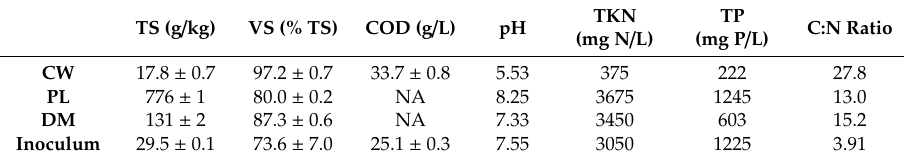
Table 2. Characterization of the substrates, cassava wastewater (CW), poultry litter (PL), and dairy manure (DM) and the inoculum source, including total solids (TS), volatile solids (VS), chemical oxygen demand (COD), pH, total Kjeldahl nitrogen (TKN), total phosphorus (TP), and the carbon to nitrogen ratio